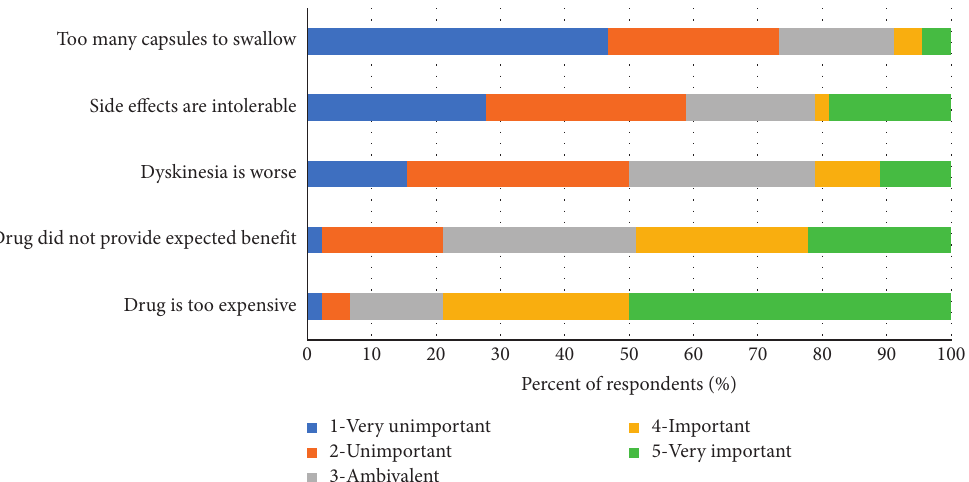
Figure 6: Importance rating of reasons why CD-LD ER is discontinued after